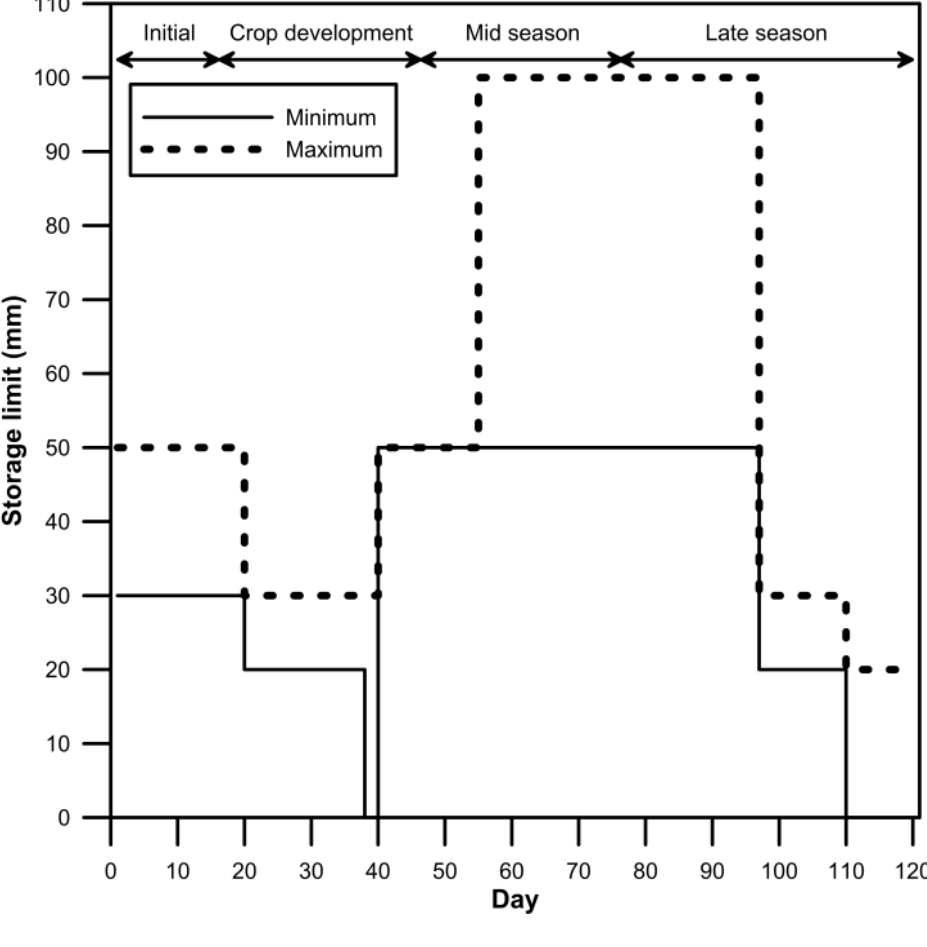
Figure 6. Suggested water depth in paddy field during cropping